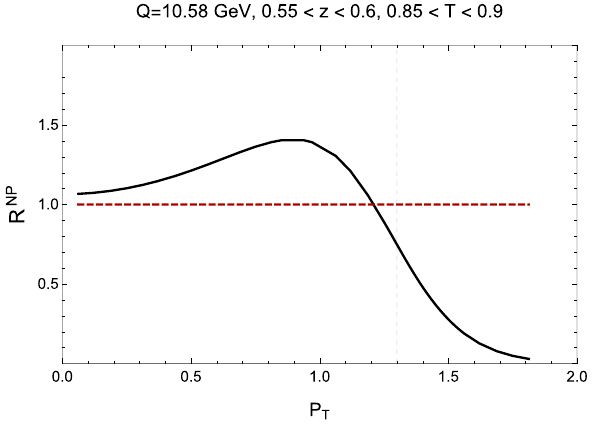
Fig. 11 The ratio between the non pertubative contributions to the cross sections calculated according to the extraction of Group B and the rapidity dilated extraction of Group A